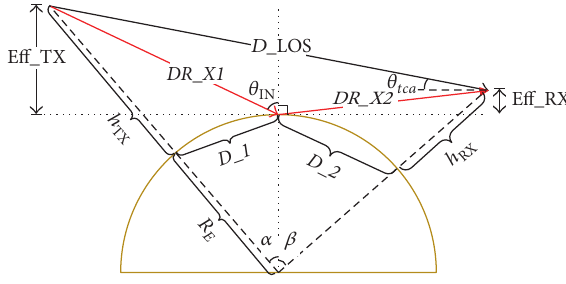
Figure 1: Round Earth Loss model.